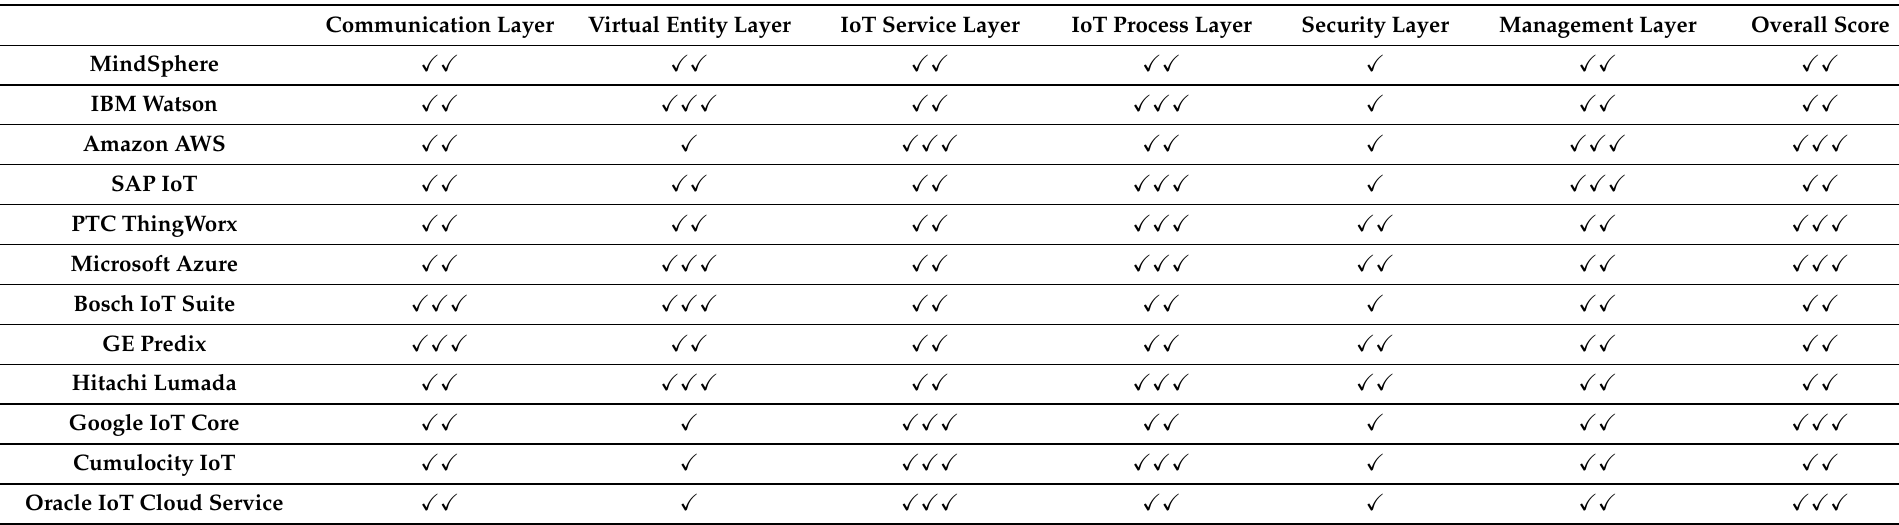
Table 1. Analysis of main IoT platforms according to the IoT-A RA ( (cid:88) basic, (cid:88)(cid:88) advanced, (cid:88)(cid:88)(cid:88) peculiar